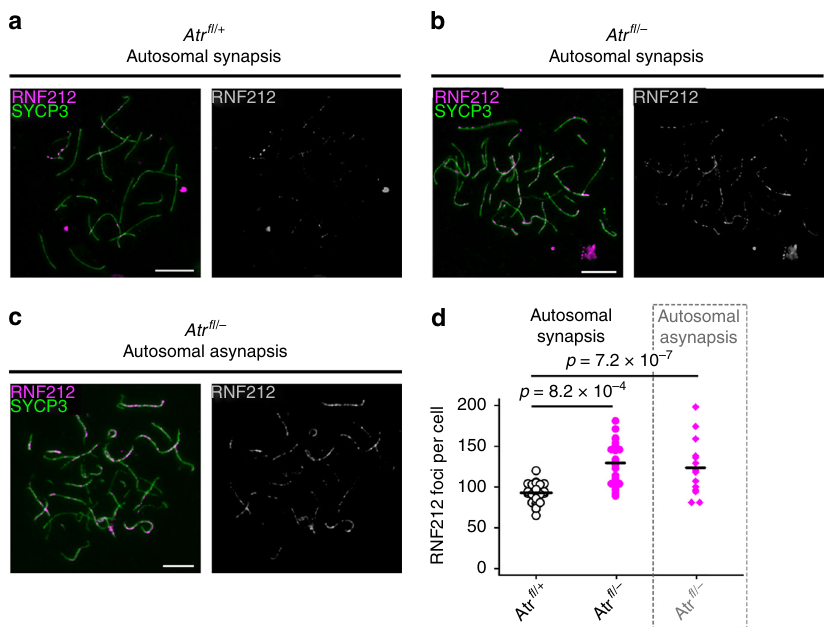
Fig. 6 ATR regulates RNF212 counts during pachynema. a – c RNF212 (magenta) and SYCP3 (green) immunostaining at early pachynema in Atr fl / + and Atr fl / – males. d RNF212 counts in Atr fl / + male ( n = 1 male; 29 cells) and Atr fl / – male with normal autosomal synapsis ( n = 1 male; 15 cells) or autosomal asynapsis ( n = 1 males; 25 cells). Mean and p values (Mann – Whitney test) indicated. Scale bars 10 µ